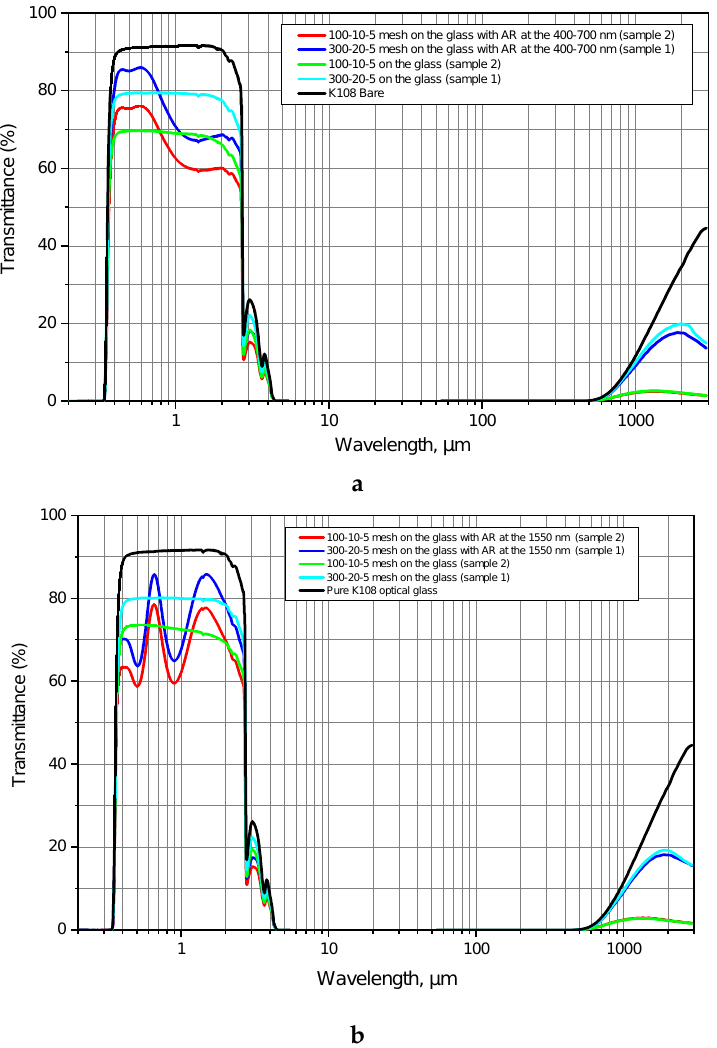
Figure 7. Transmission spectra of mesh structures with AR coating at 1.55 µm ( a ) and in the visible range ( b ) as well as without AR